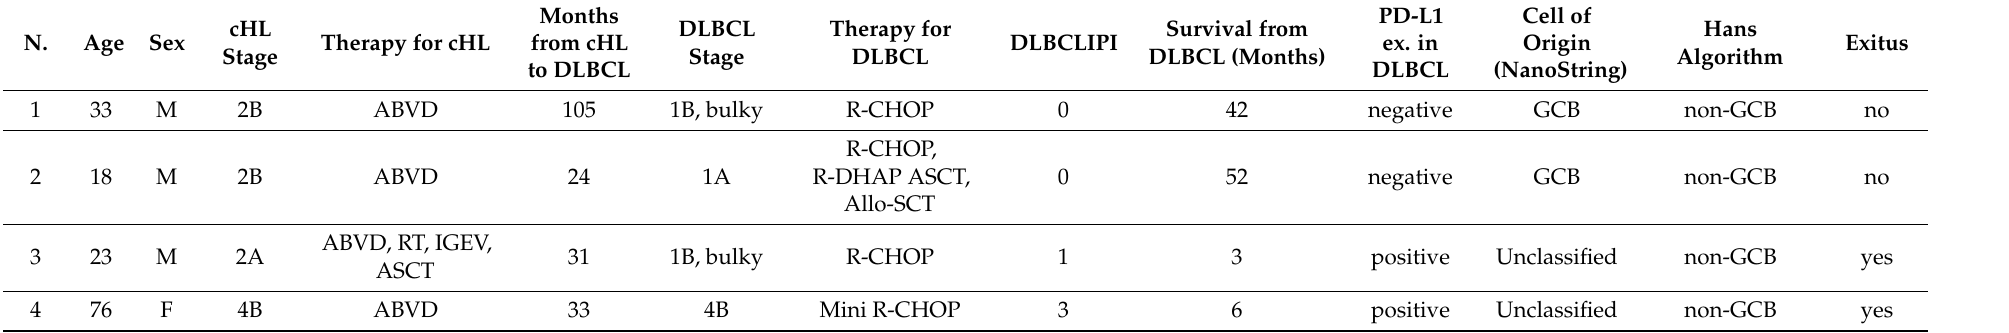
Table 1. Clinical, treatment, cell of origin, immunohistochemistry, and survival characteristics.